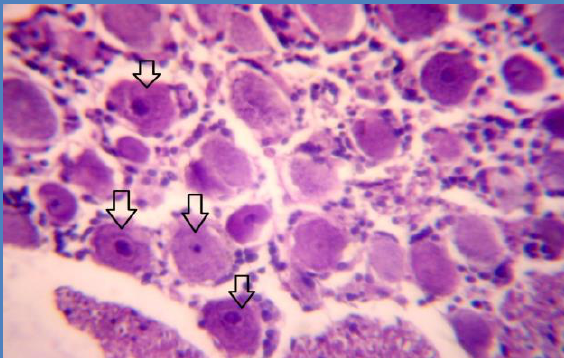
Figure, 4: Maturation group, sensory neurons normal staining and normal size (arrows). 40X, H and E.